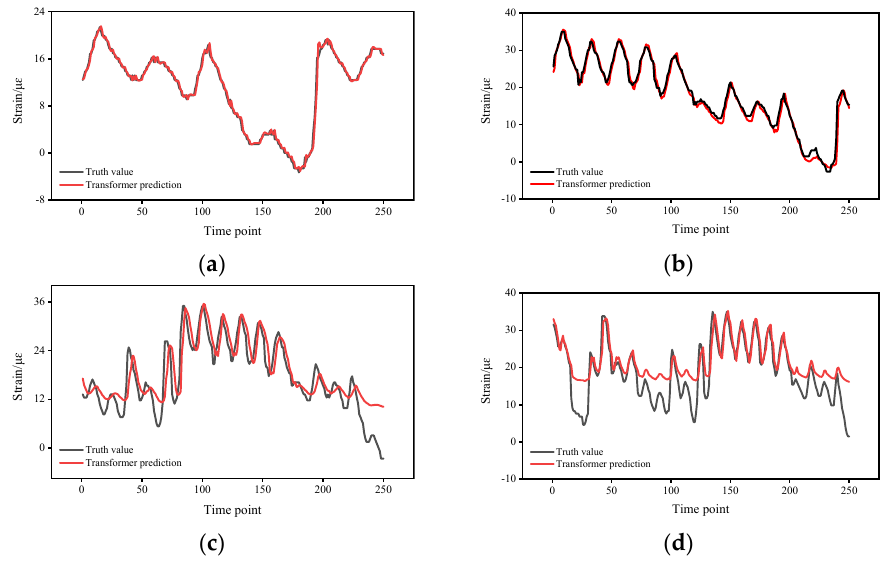
Figure 8. Prediction results at different time intervals. ( a ) 0.5 h. ( b ) 1 h. ( c ) 1.5 h. ( d ) 2 h.